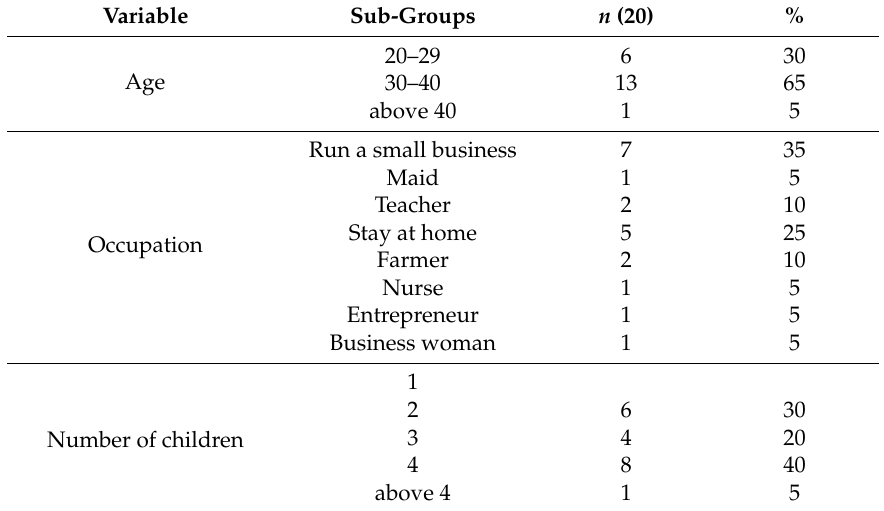
Table 2. Demographic description of participants by age group, occupation, and number of